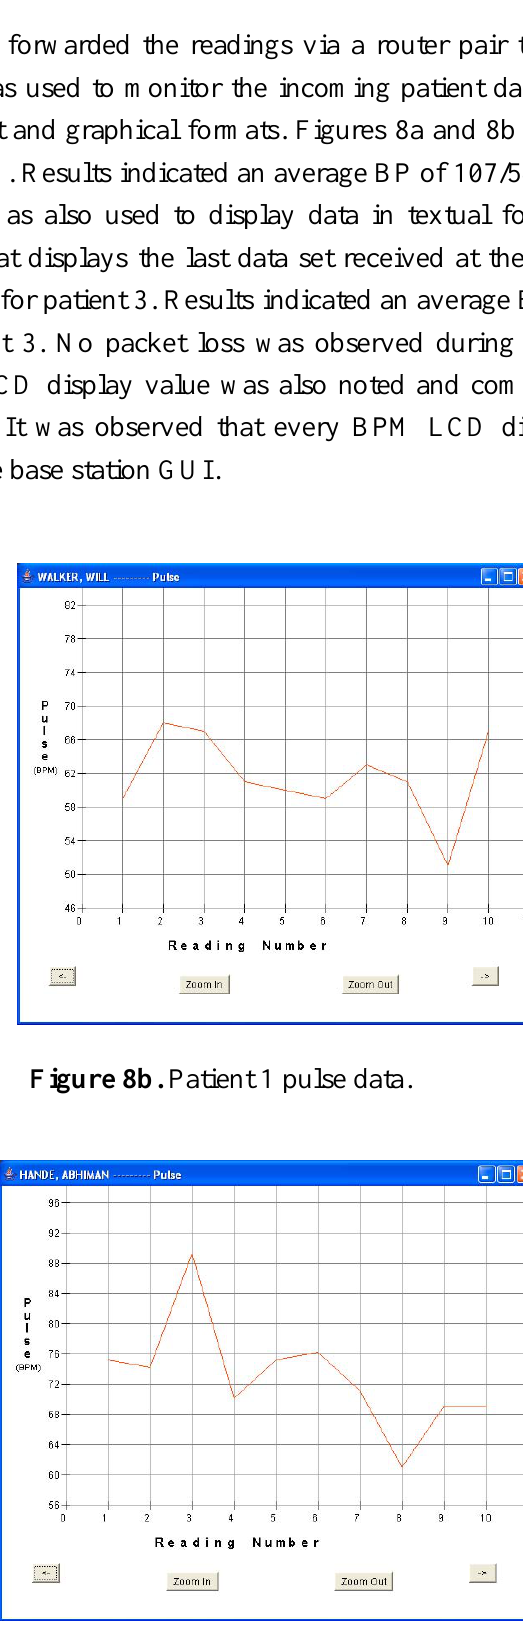
Figure 9a. Patient 3 BP data. Figure 9b. Patient 3 pulse